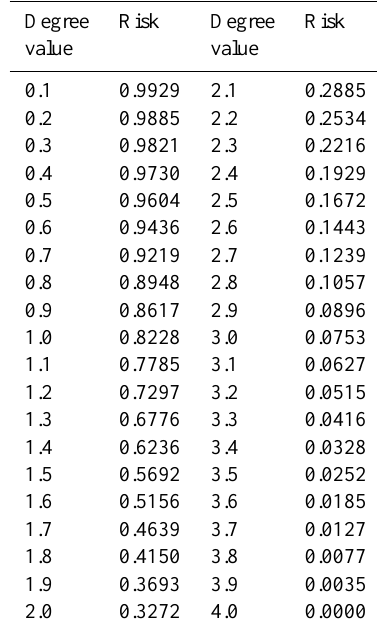
Table 6. Comparison of three methods. Table 7. The disaster risk